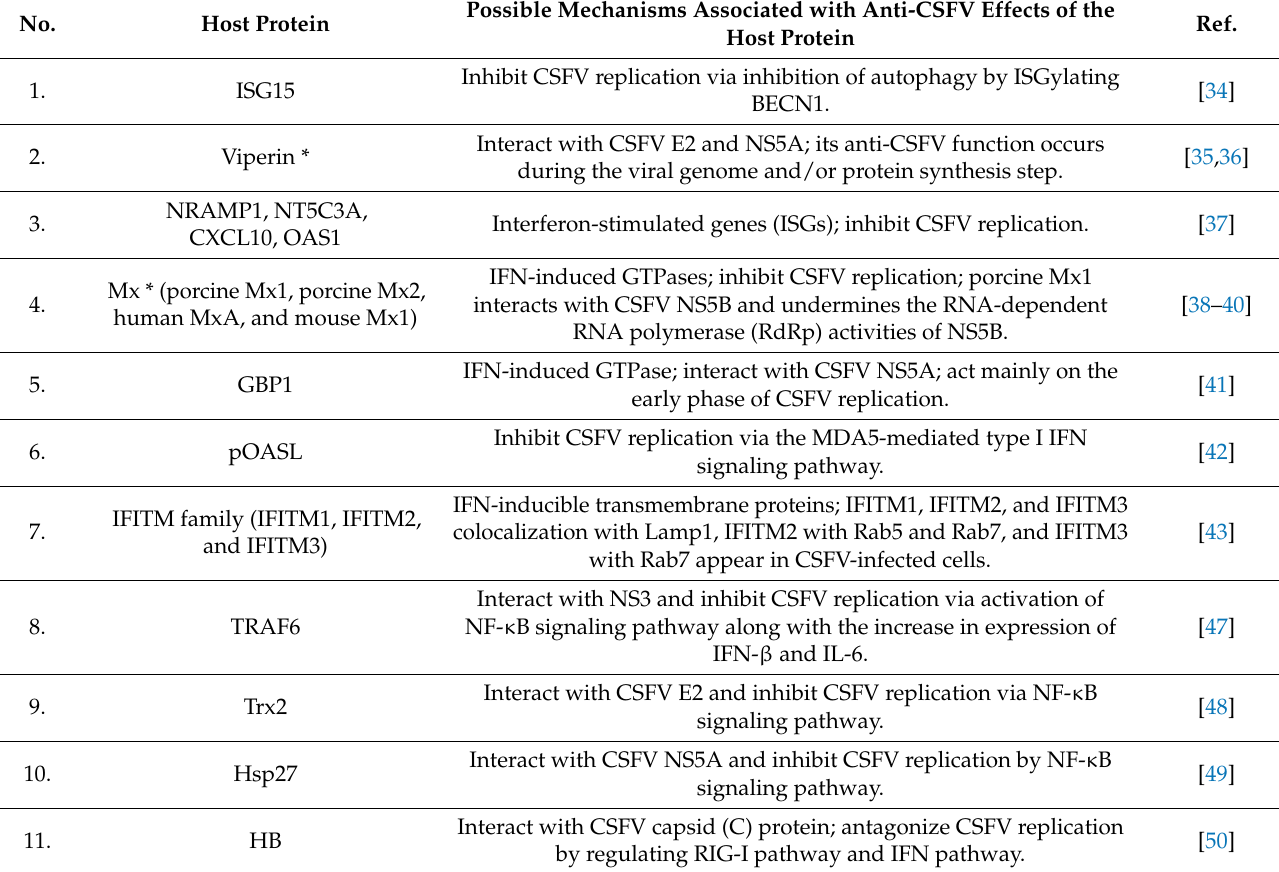
Table 1. Host proteins with anti-classical swine fever virus (CSFV)